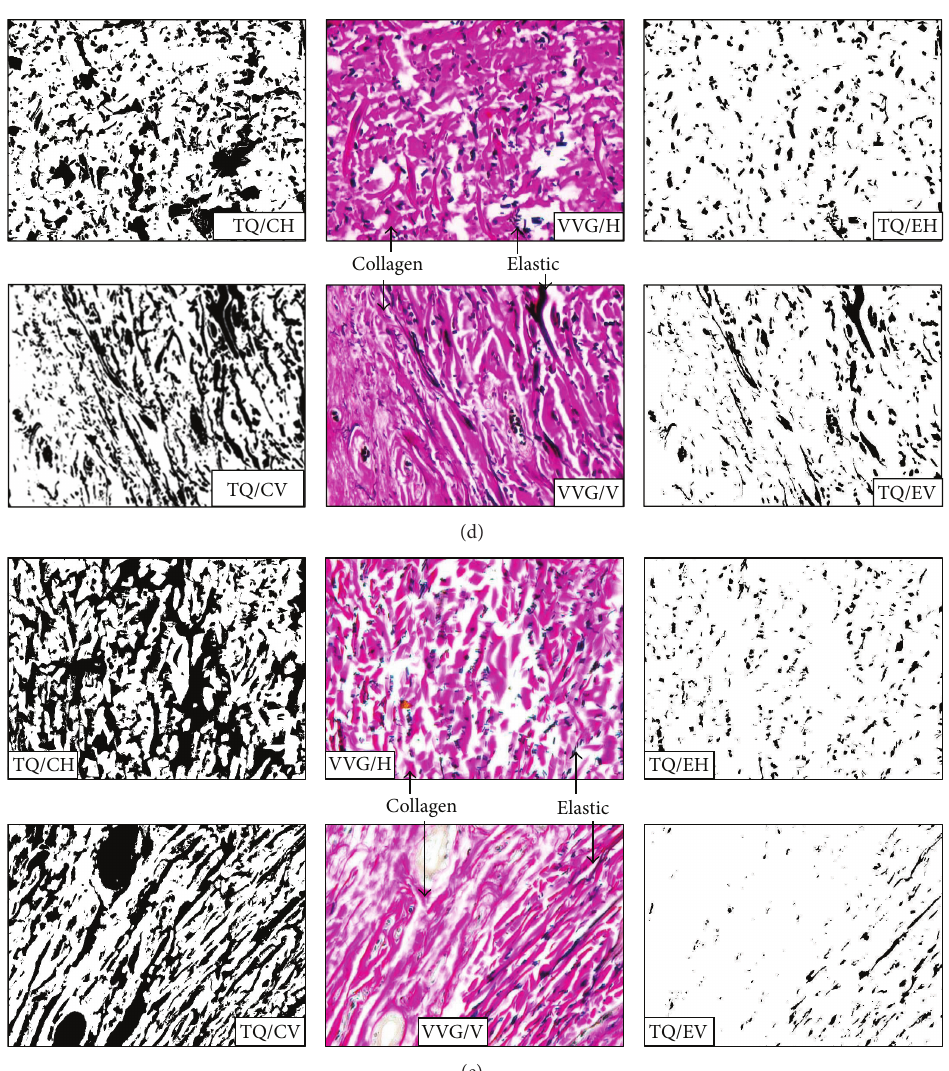
Figure 2: Photograph showing the pattern of collagen (stained pink) and elastic (black stain) fibres as in Verhoeff-van Gienson (VVG) stain ( × 20)inhorizontal(VVG/H)andvertical(VVG/V)samplesofupperback(a),presternal(b),lateralchest(c),abdomen(d),andgroin(e)areas of trunk region. Segmentation of collagen and elastic fibres by tissue-quant (TQ) image analysis is shown in adjacent photographs. TQ/CH and TQ/EH: for collagen and elastic fibres in horizontal section, respectively, and TQ/CV and TQ/EV: as in vertical sections,